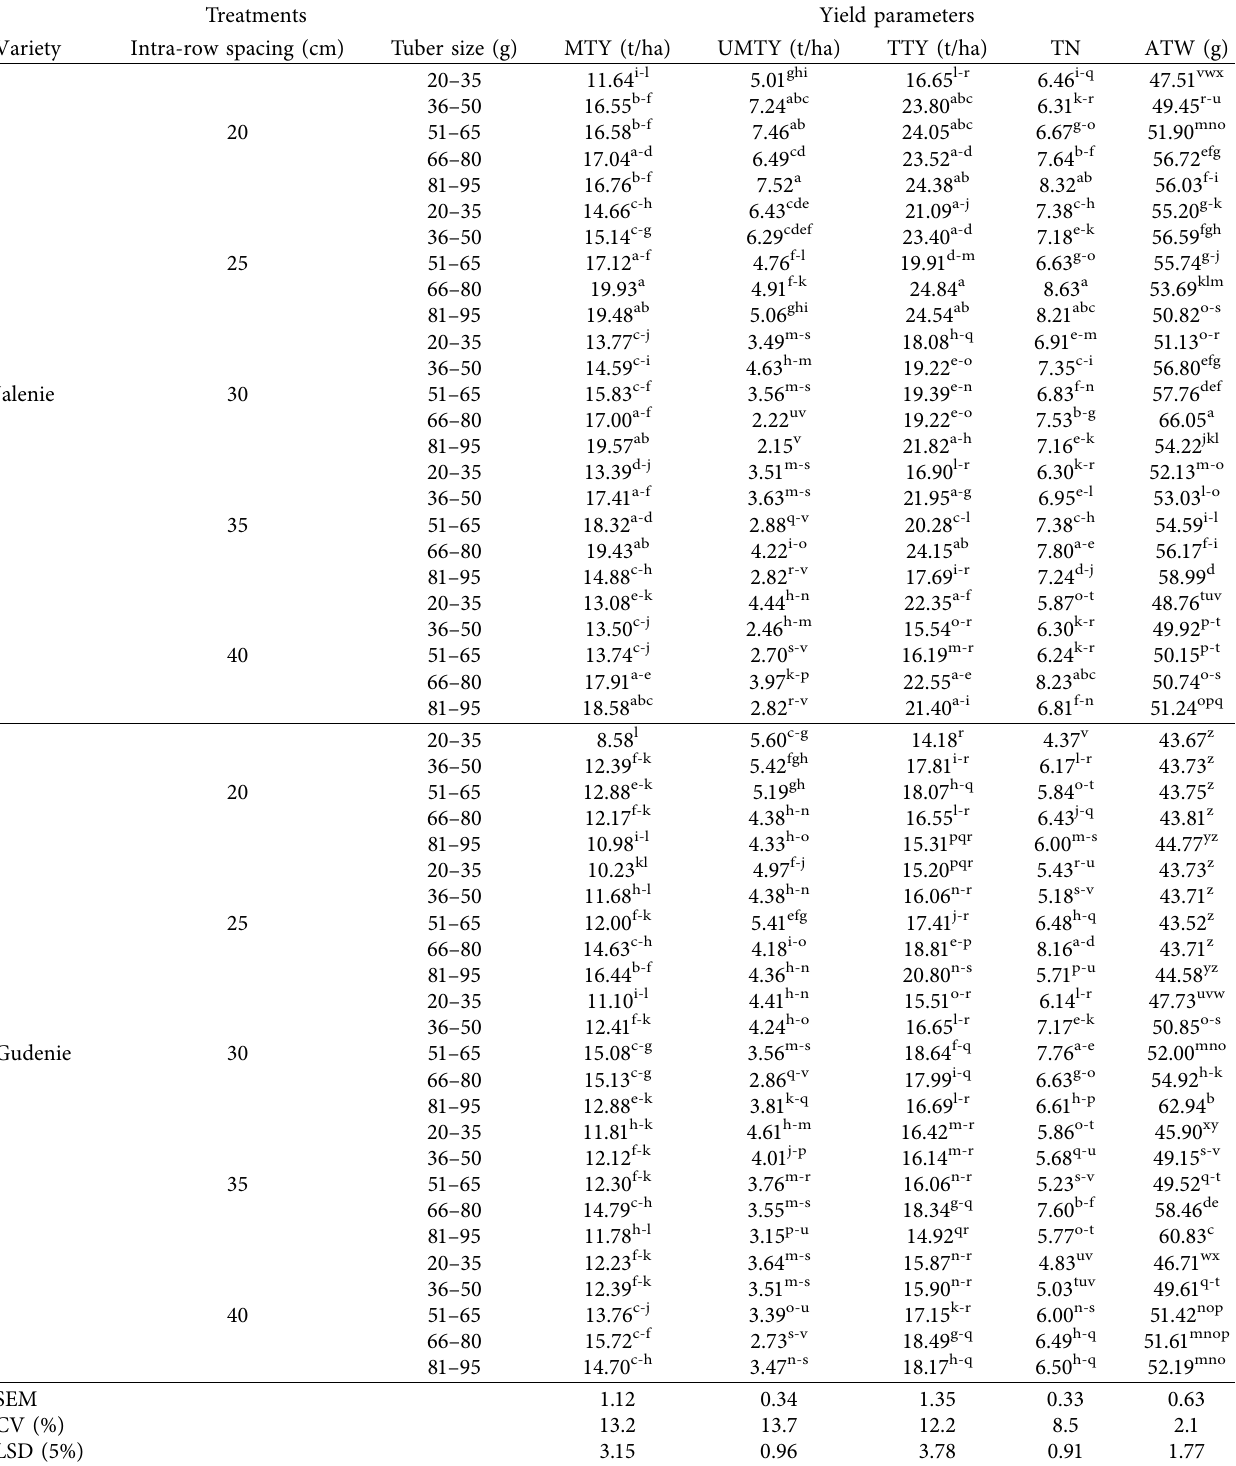
Table 6: Interaction effects of variety, intra-row spacing, and tuber size on yield parameters of potato in 2013/2014 at Nono Benja. Treatments Yield parameters Variety Intra-row spacing (cm) ATW